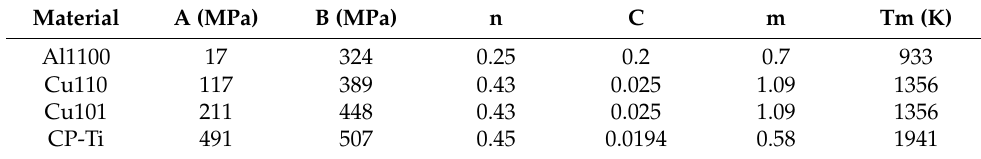
Table 4. Johnson–Cook material model parameters, Al1100 [15], Copper alloys [16], CP-Ti